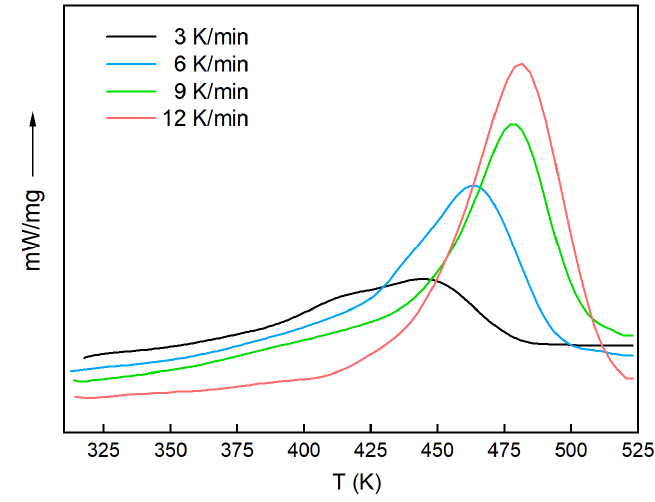
Figure 2. The DSC curves at different heating rates.